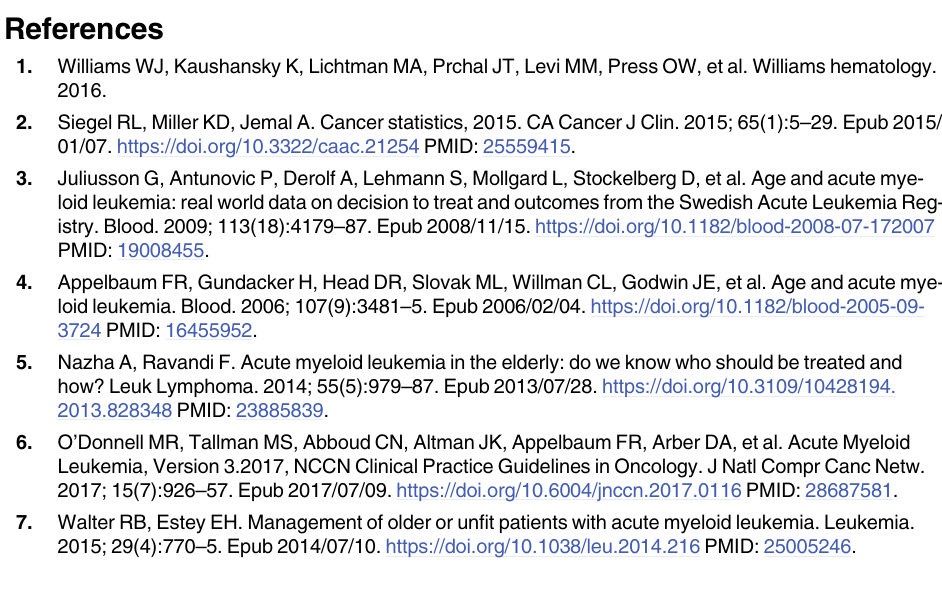
S1 Fig. Overall survival (OS) curves of non–acute promyelocytic leukemia (APL) patients by age group (A), cytogenetic risk (B), and versus APL (C) patients. (TIF) S2 Fig. Overall survival (OS) curves of non–acute promyelocytic leukemia patients with (A) or without (B) FLT3-ITD mutations and intermediate-risk patients with (C) or with- out (D) FLT3-ITD mutations.